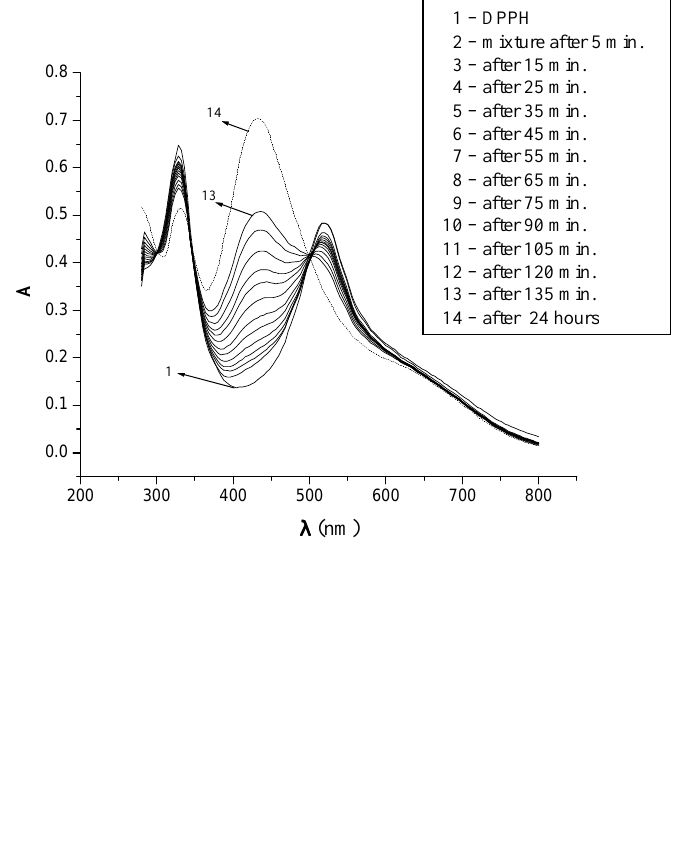
= 428 nm) from 1a ( l = 520 max max = 2